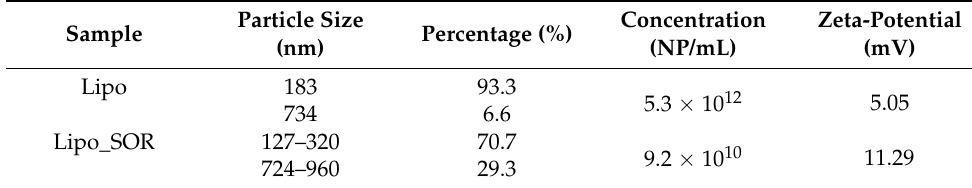
Table 1. The particle size, concentration, and zeta-potential of liposomes.